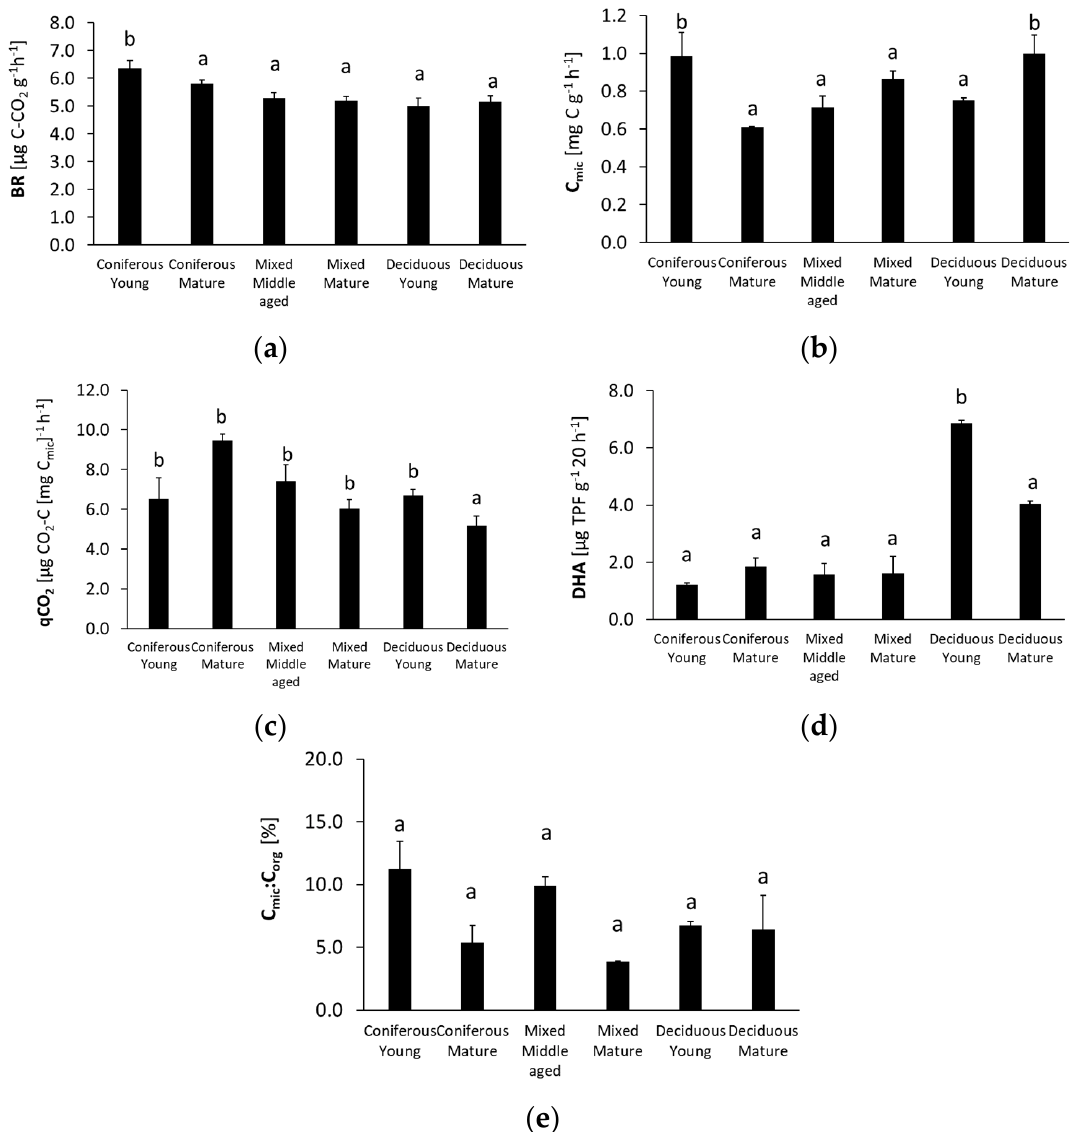
Figure 2. Annual mean microbial parameters of soils: ( a ) BR—basal respiration; ( b ) C mic —microbial biomass; ( c ) qCO 2 —metabolic quotient; ( d ) DHA—dehydrogenase activity, ( e ) and C mic :C org ratio) collected from different forests (average values ± standard deviation). Different letters indicate significant differences (a non-parametric Kruskal–Wallis test, p < 0.05, was carried out separately for each parameter and for each forest).